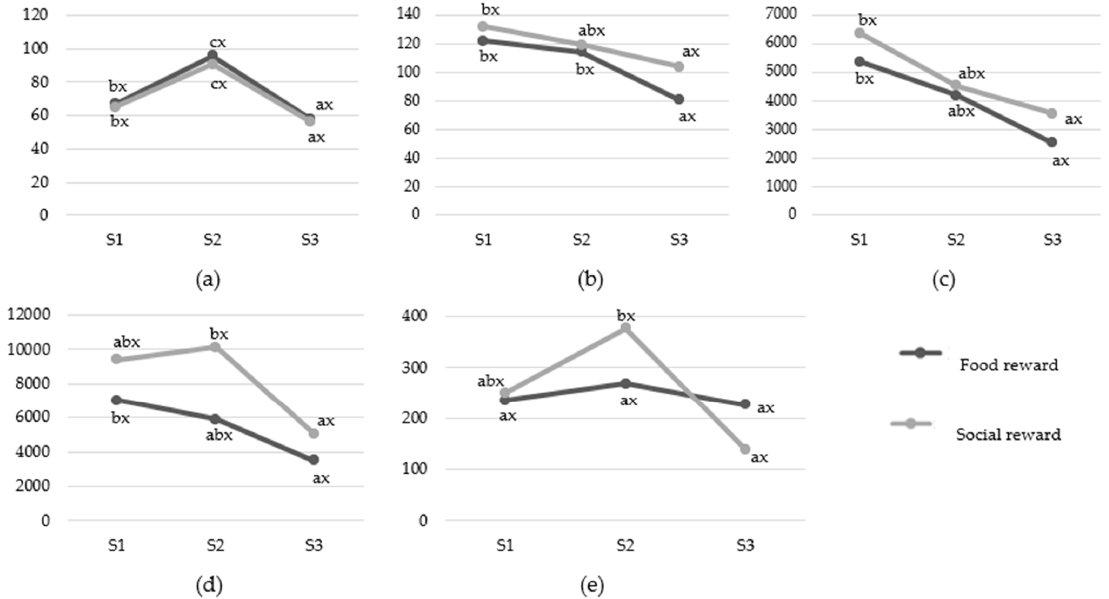
Figure 3. Mean values of: ( a ) HR [bpm]; ( b ) RMSSD [ms]; ( c ) HF [ms 2 ]; ( d ) LF [ms 2 ]; ( e ) LF/HF [%]